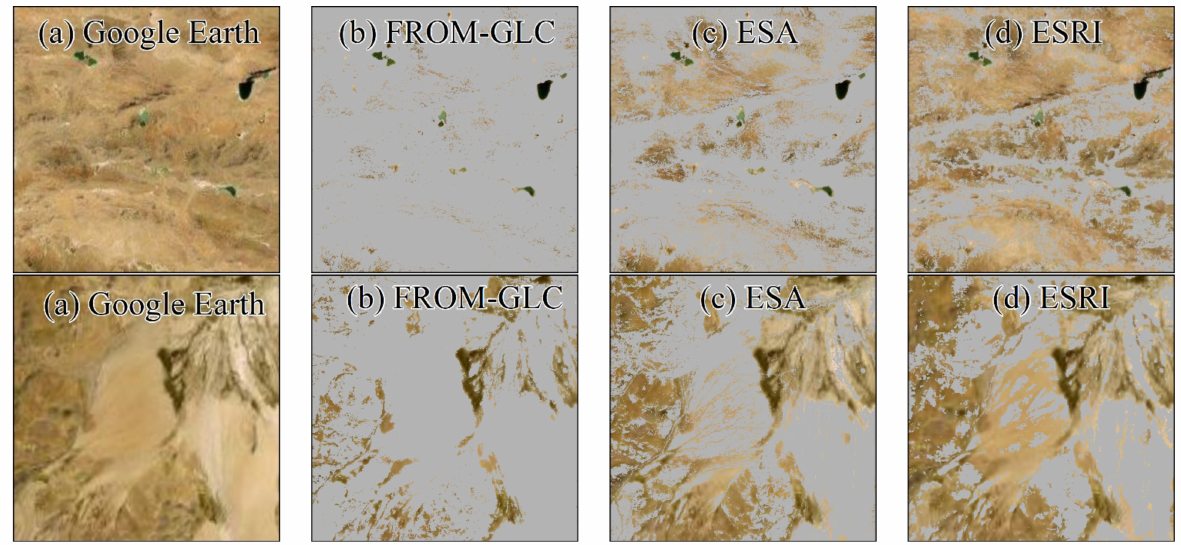
Figure 13. Visual comparison of bareland type with Google Earth image (Grey is bareland): ( a ) Google Earth, ( b ) FROM-GLC, ( c ) ESA, ( d )